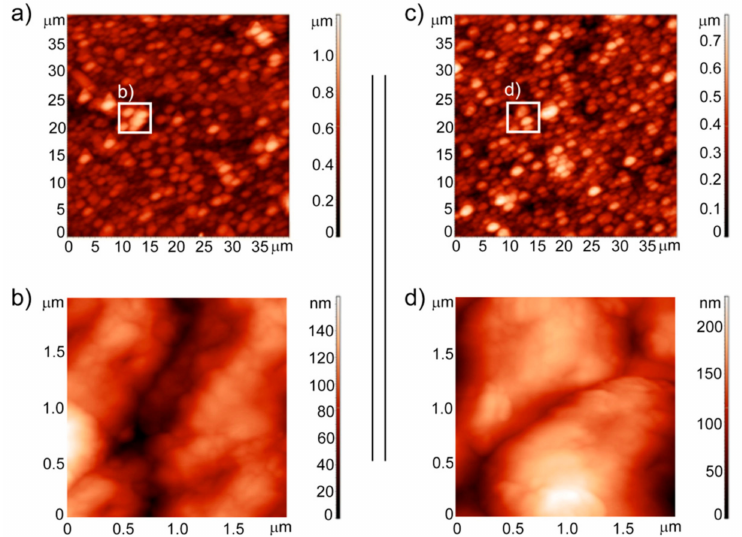
Figure 1. AFM topography of Ag-SiO 2 measured at ( a , c ) (40 × 40) µ m and at ( b , d ) (2 × 2) µ m. The AFM images are visualized for the Ag-SiO 2 coating before sintering ( left panels) and after sintering at 700 ◦ C/2 h ( right